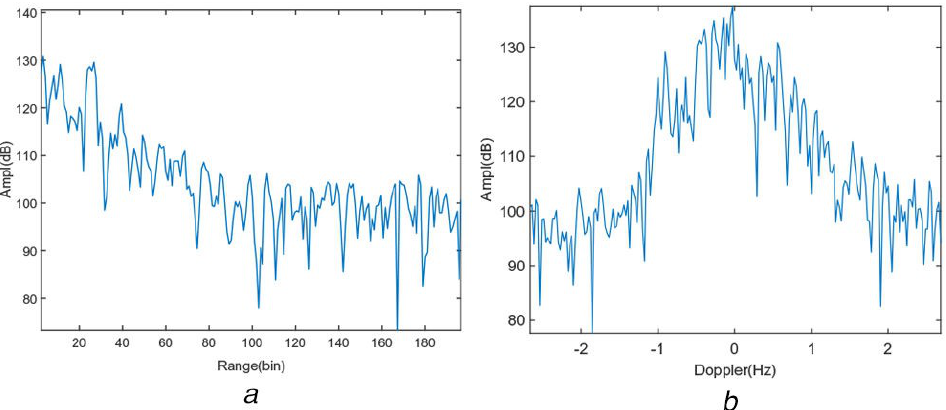
Fig. 6 Simulation results of Weibull distribution clutter